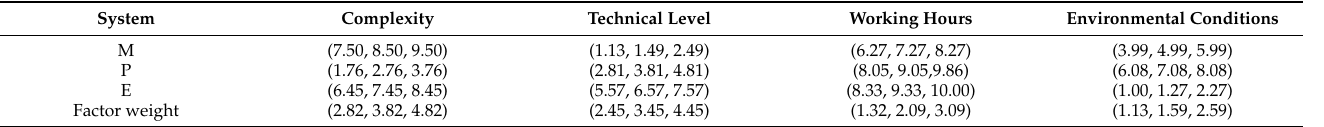
Table 5. Evaluation factors and weight analysis table of the loading and unloading truss robot for CNC